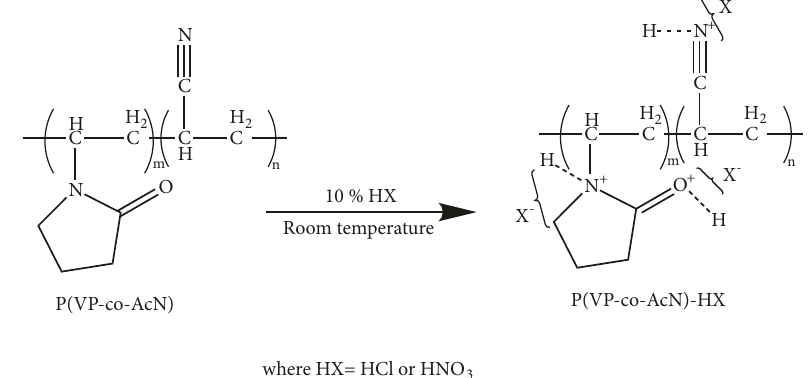
Figure 2: Schematic representation for the synthesis of the polyelectrolytes, P(VP-co-AcN)-HCl/HNO 3 .